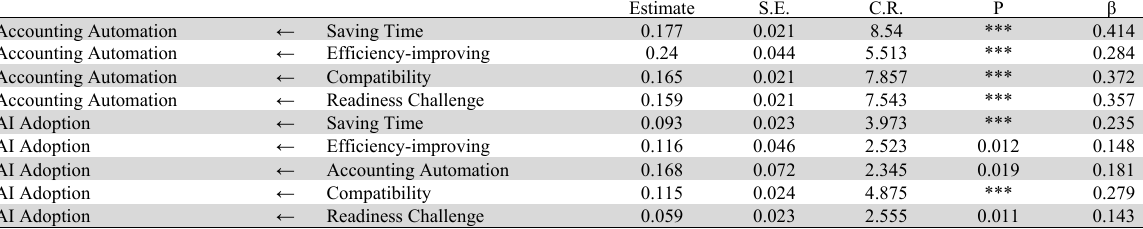
Regression Weights for Digital transformation vision